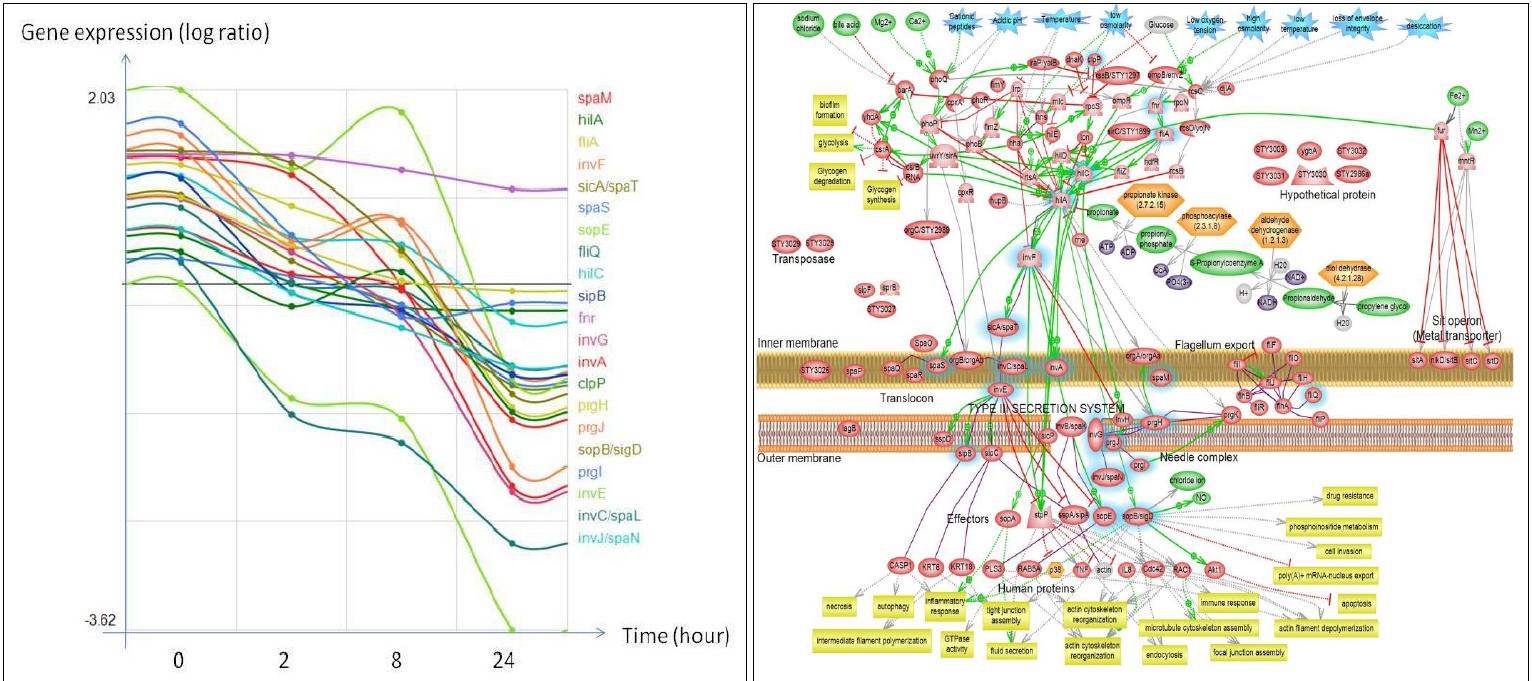
Figure 11a: Cluster 1A. This cluster consists of genes which have positive correlation. It appears that this group of genes plays a significant role especially during invasion in the macrophage (left). The expression profile corresponds to the proteins as highlighted in blue. It clearly depicts that the signals are being transmitted from the regulator to the Type III secretion system proteins and effector proteins which finally interact with the human proteins (right). Cluster 1A also revealed that many genes in SPI-1 pathway have expression profile similar to hilA and hilC profile, suggesting that the genes in this cluster are under stringent control of these two transcription factors. Their common expression profile also supports functional commonality of proteins in SPI-1 pathway. The most upstream transcription factor in this cluster is oxygen sensor fnr that controls the expression of fliA sigma factor to turn on hilA and hilC expression. This suggests that low oxygen concentration is the main trigger initiating genetic program for invasion of macrophages. Our findings are consistent with previously reported fnr role for Salmonella survival inside the host cells